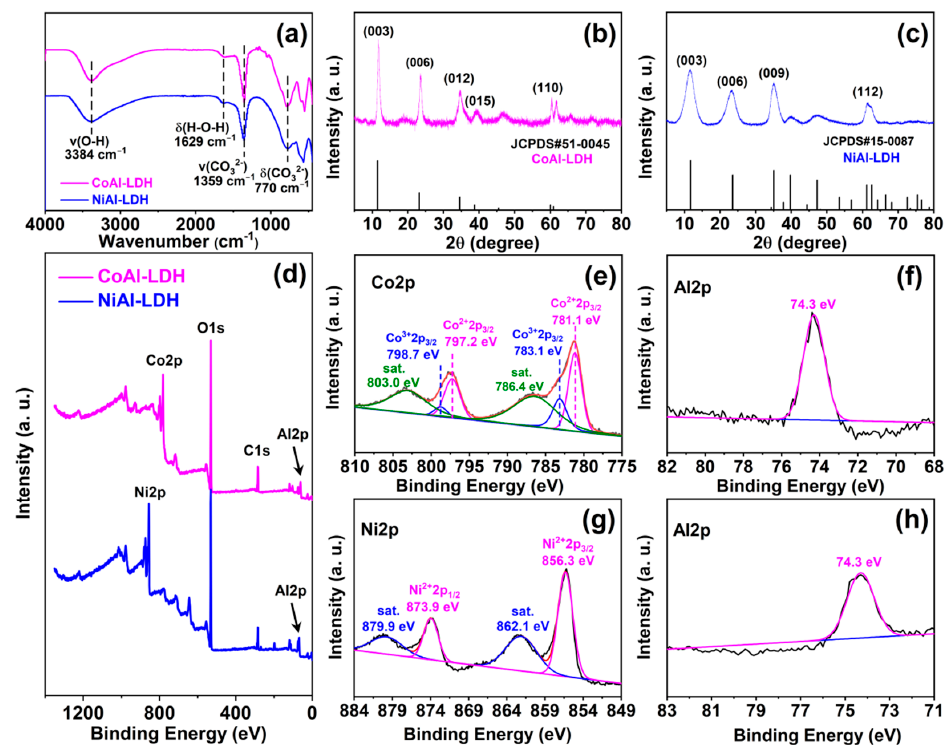
Figure 1. ( a ) FTIR spectra of CoAl-LDH and NiAl-LDH; XRD patterns of ( b ) CoAl-LDH and ( c ) NiAl-LDH; ( d ) XPS total survey spectra of CoAl-LDH and NiAl-LDH; ( e ) Co2p and ( f ) Al2p spectra of CoAl-LDH; ( g ) Ni2p and ( h ) Al2p spectra of NiAl-LDH. Table 1. The corresponding data from the ICP-OES test.